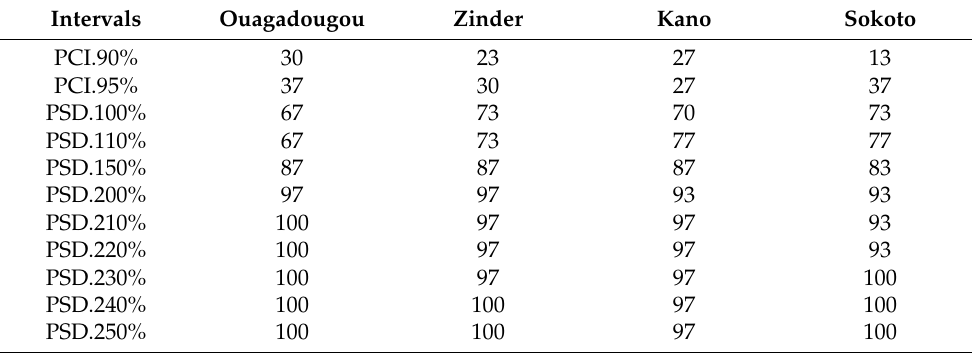
Table 3. Proportion of years during the reference period involved in the intervals around the reference